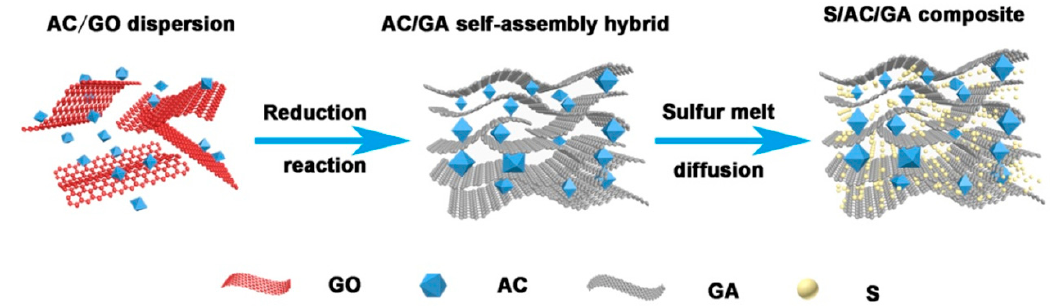
Figure 1. Schematic diagram of fabrication of sulfur/activated carbon/graphene (reduced graphene oxide) aerogel (S/AC/GA) composite.